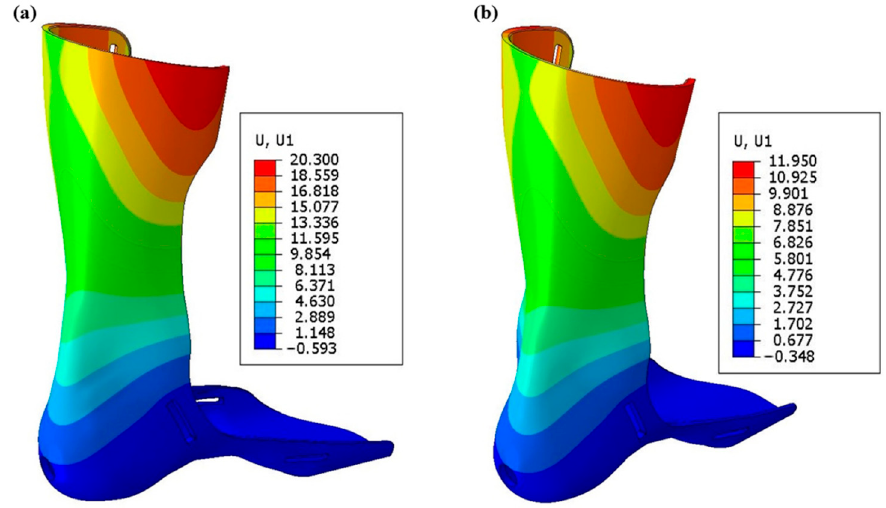
Figure 6. Simulated deformation distribution of ( a ) PLA and ( b ) PLA-C. Table 4. Experimental and predicted displacements of AFOs at 160 N